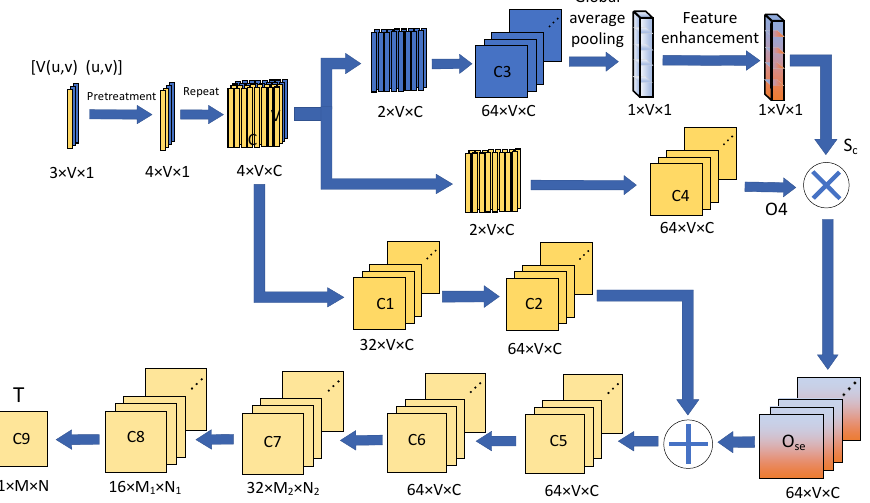
Figure 3. Structure of the IASR–CNN.